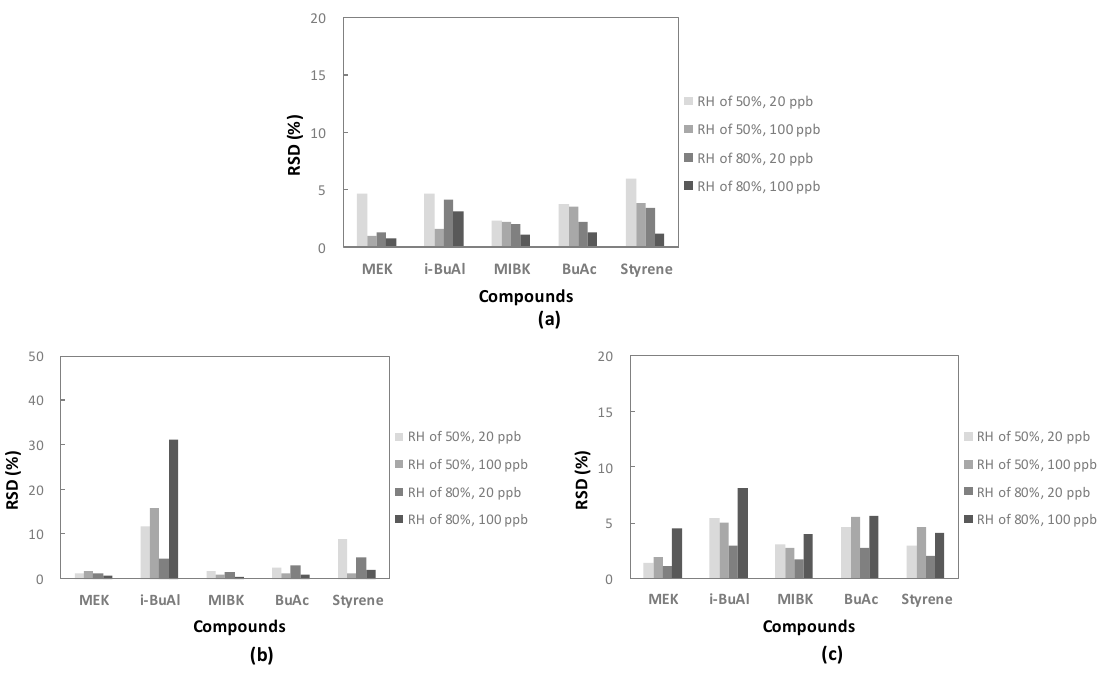
Figure 4. Reproducibility of odorous compounds after removing water vapor: ( a ) Desolvator-K; ( b ) Cooler-G; ( c ) Cooler-K.